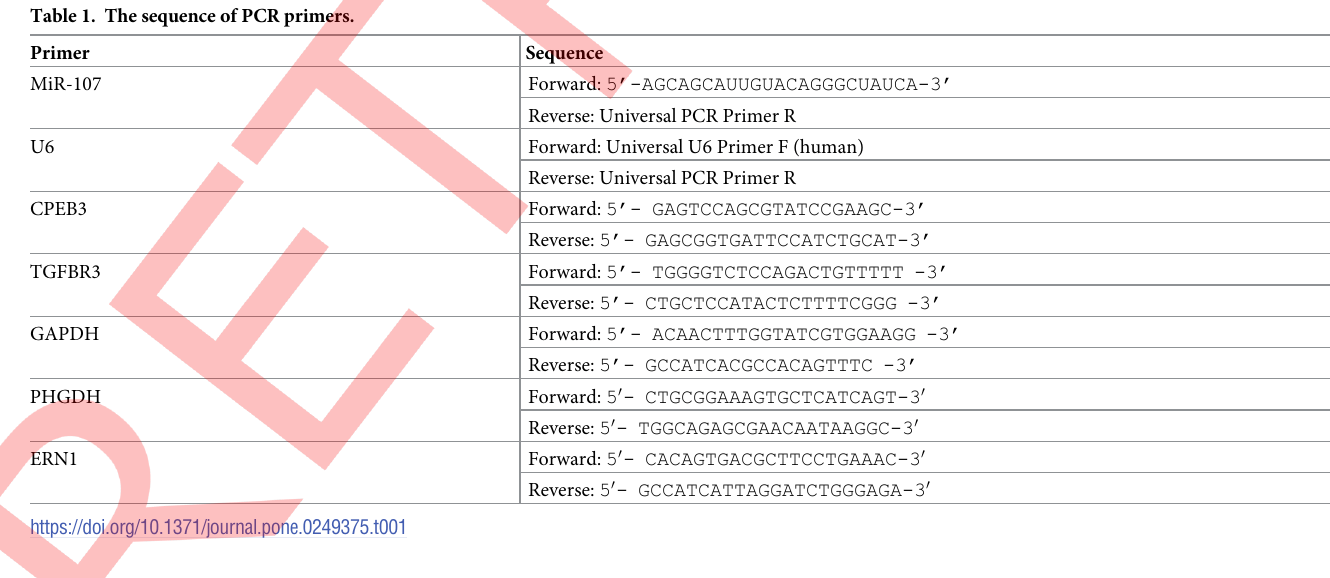
Table 1. The sequence of PCR